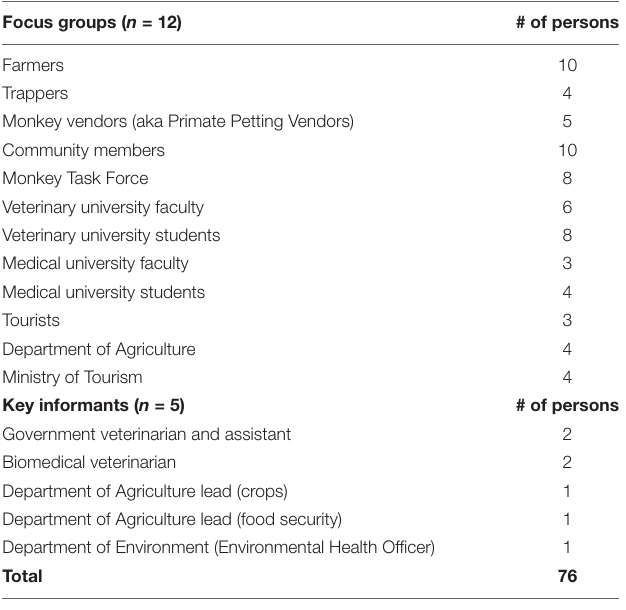
TABLE 1 | List of 17 stakeholder groups.